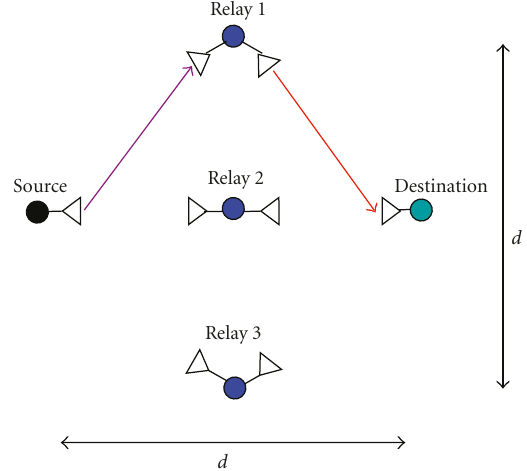
Figure 1: Scheme of the proposed relaying strategy.